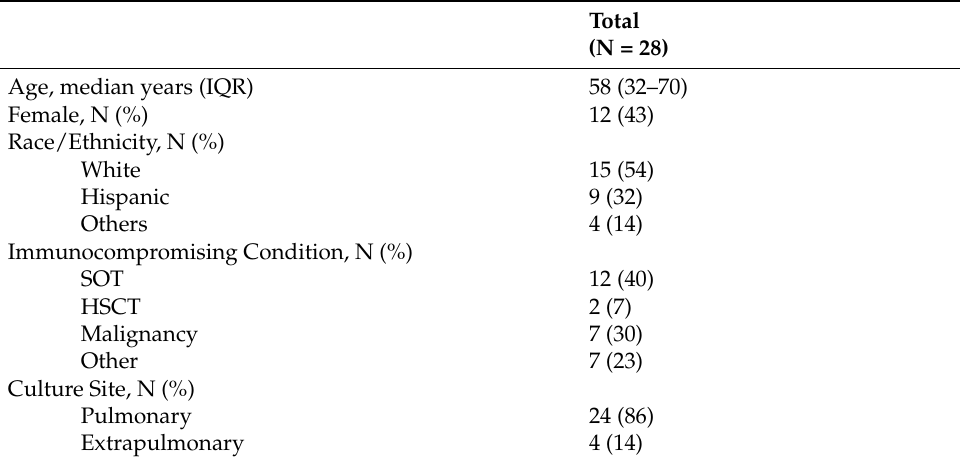
Table 1. Demographic and clinical characteristics of immunocompromised patients with culture- positive coccidioidomycosis.